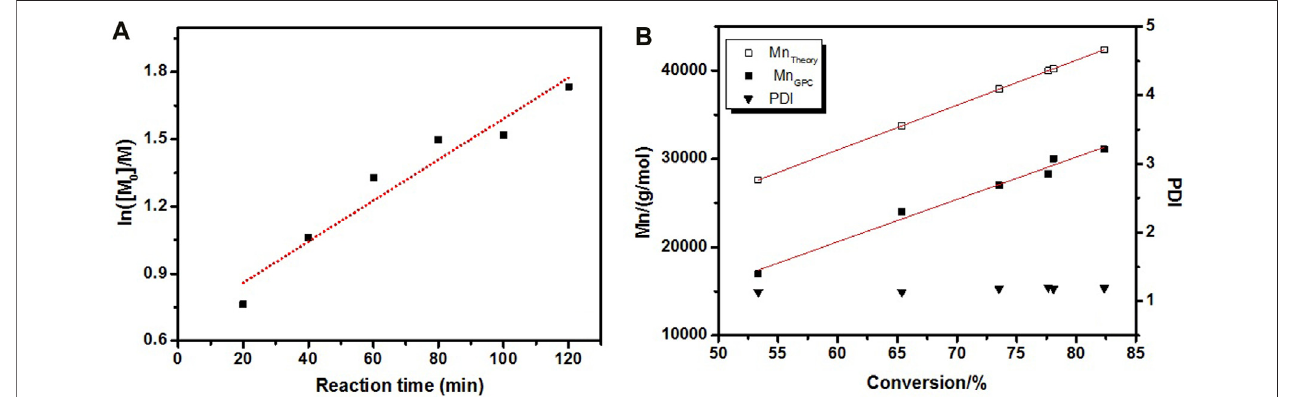
FIGURE 3 | Kinetic plots for the polymerization of LMA (A) and evolution of the M n (theoretical and GPC) and PDI (B) .